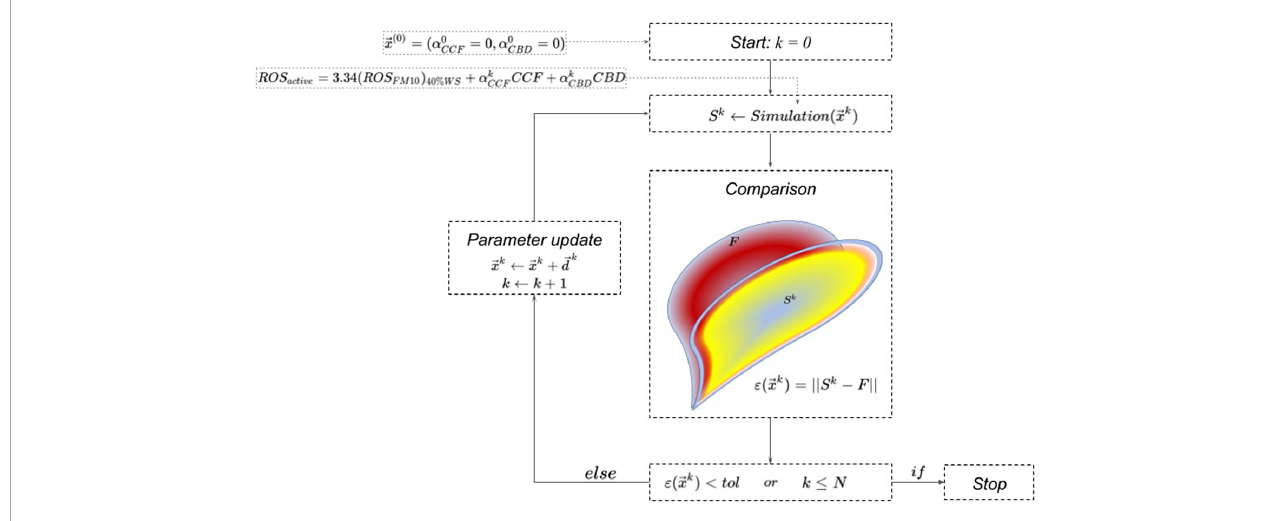
FIGURE2 Automatic adjustment of simulation parameters by comparing the outputs of simulations and real fire